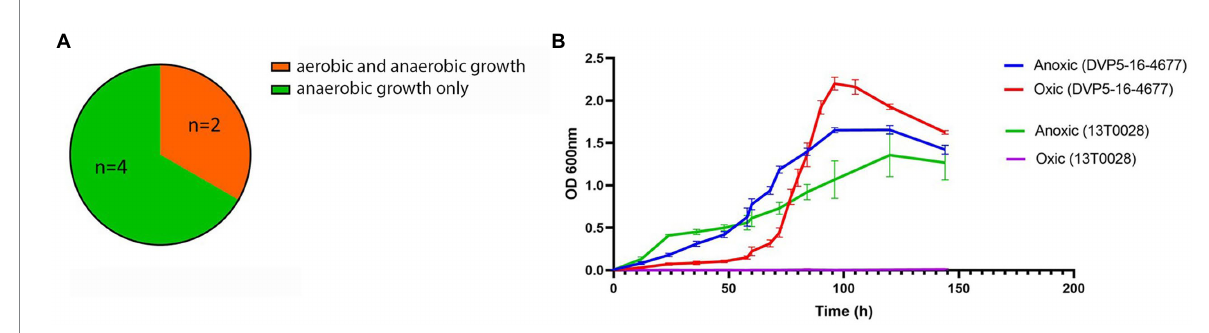
FIGURE 1 Growth kinetics of S. saccharolyticus in the presence and absence of oxygen. (A) Illustration of results of growth experiments under oxic and anoxic conditions of six different strains of S. saccharolyticus. (B) The growth curves of two strains of S. saccharolyticus (13 T0028, subclade 1; DVP5-16-4677, subclade 2) grown under oxic and anoxic conditions are depicted. The data are representative of three independent experiments.